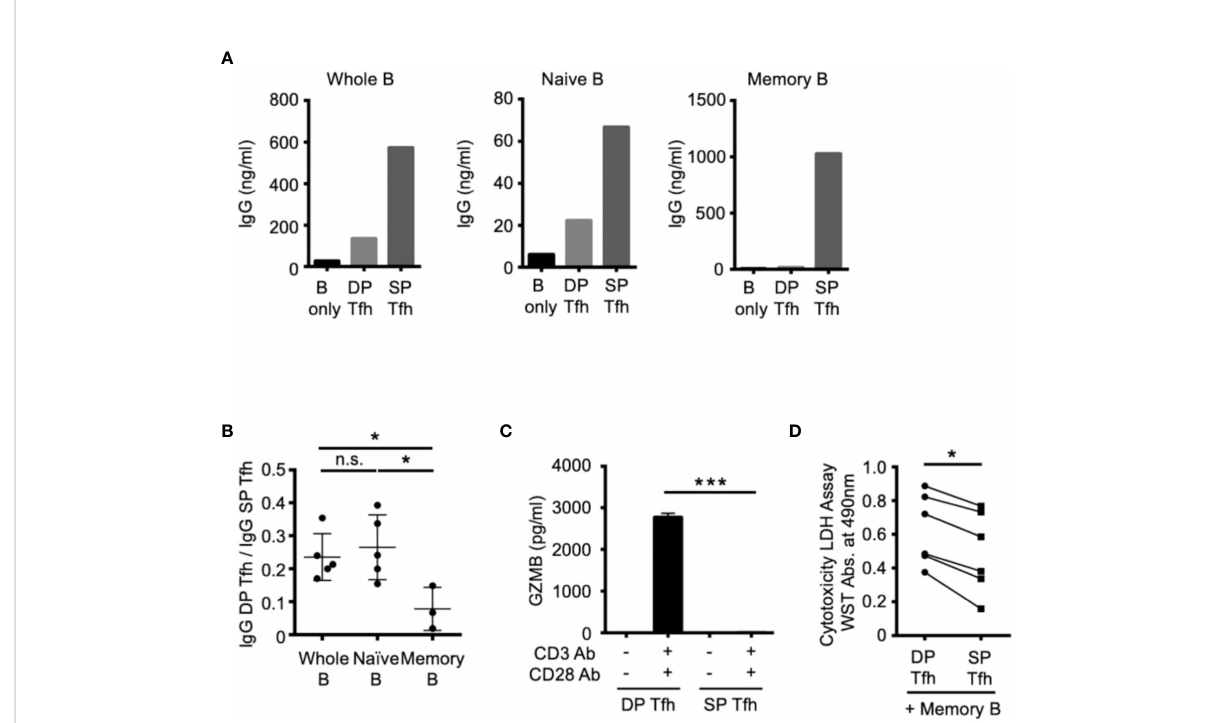
FIGURE 4 Functional effects of DP-Tfh cells on B-cell regulation. (A) Representative graphs of co-culture experiments to examine antibody production using autologous Tfh and B cells sorted from tonsil specimens (n = 3-5). DP-Tfh cells (CD3 + CD4 + CD8 + CXCR5 hi PD-1 hi ) or SP-Tfh